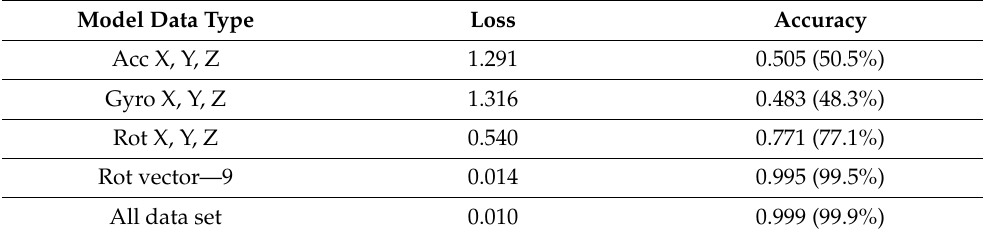
Table 3. Loss and accuracy of the